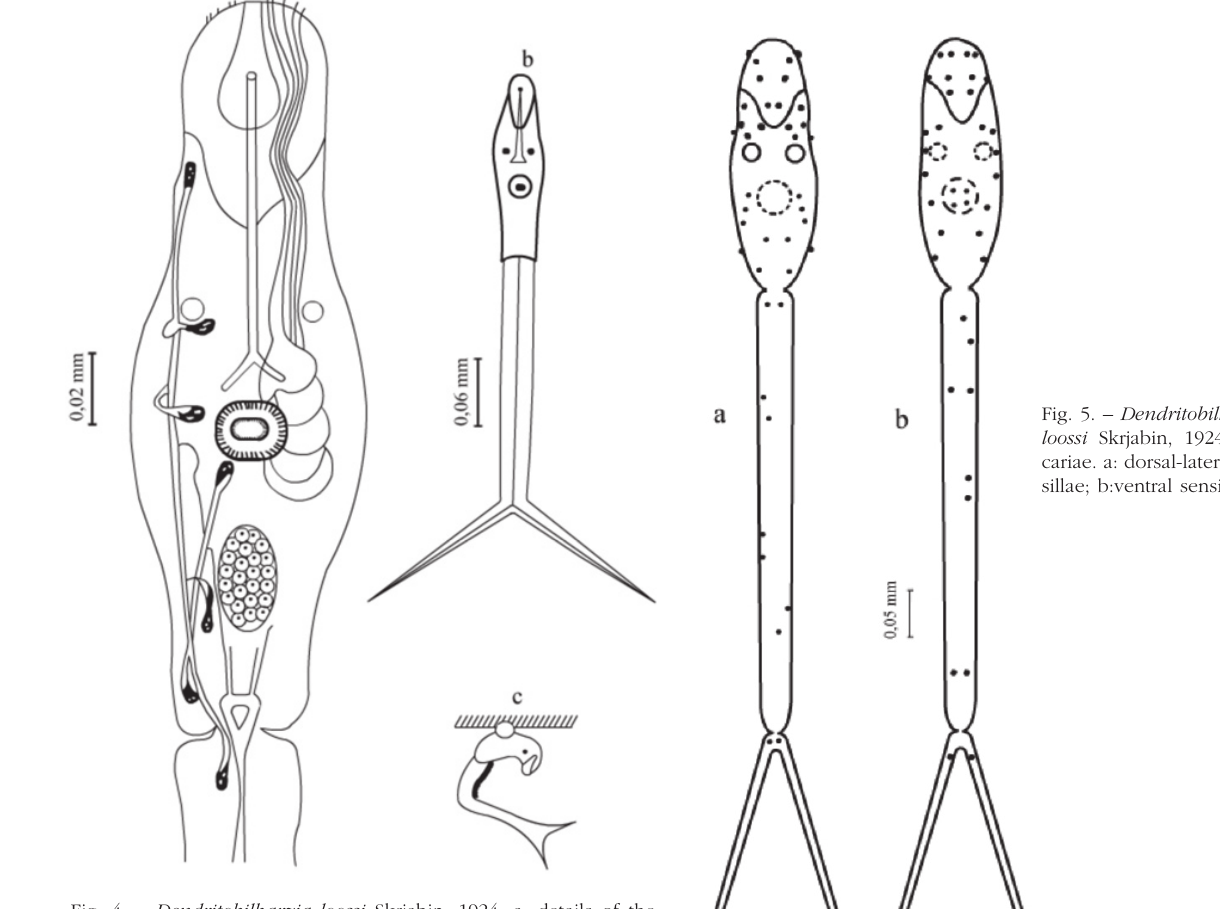
43 Original contribution